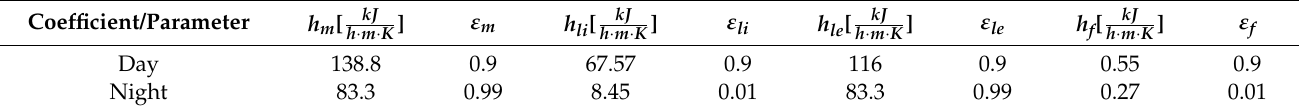
Table 2. Convection and radiation coefficient